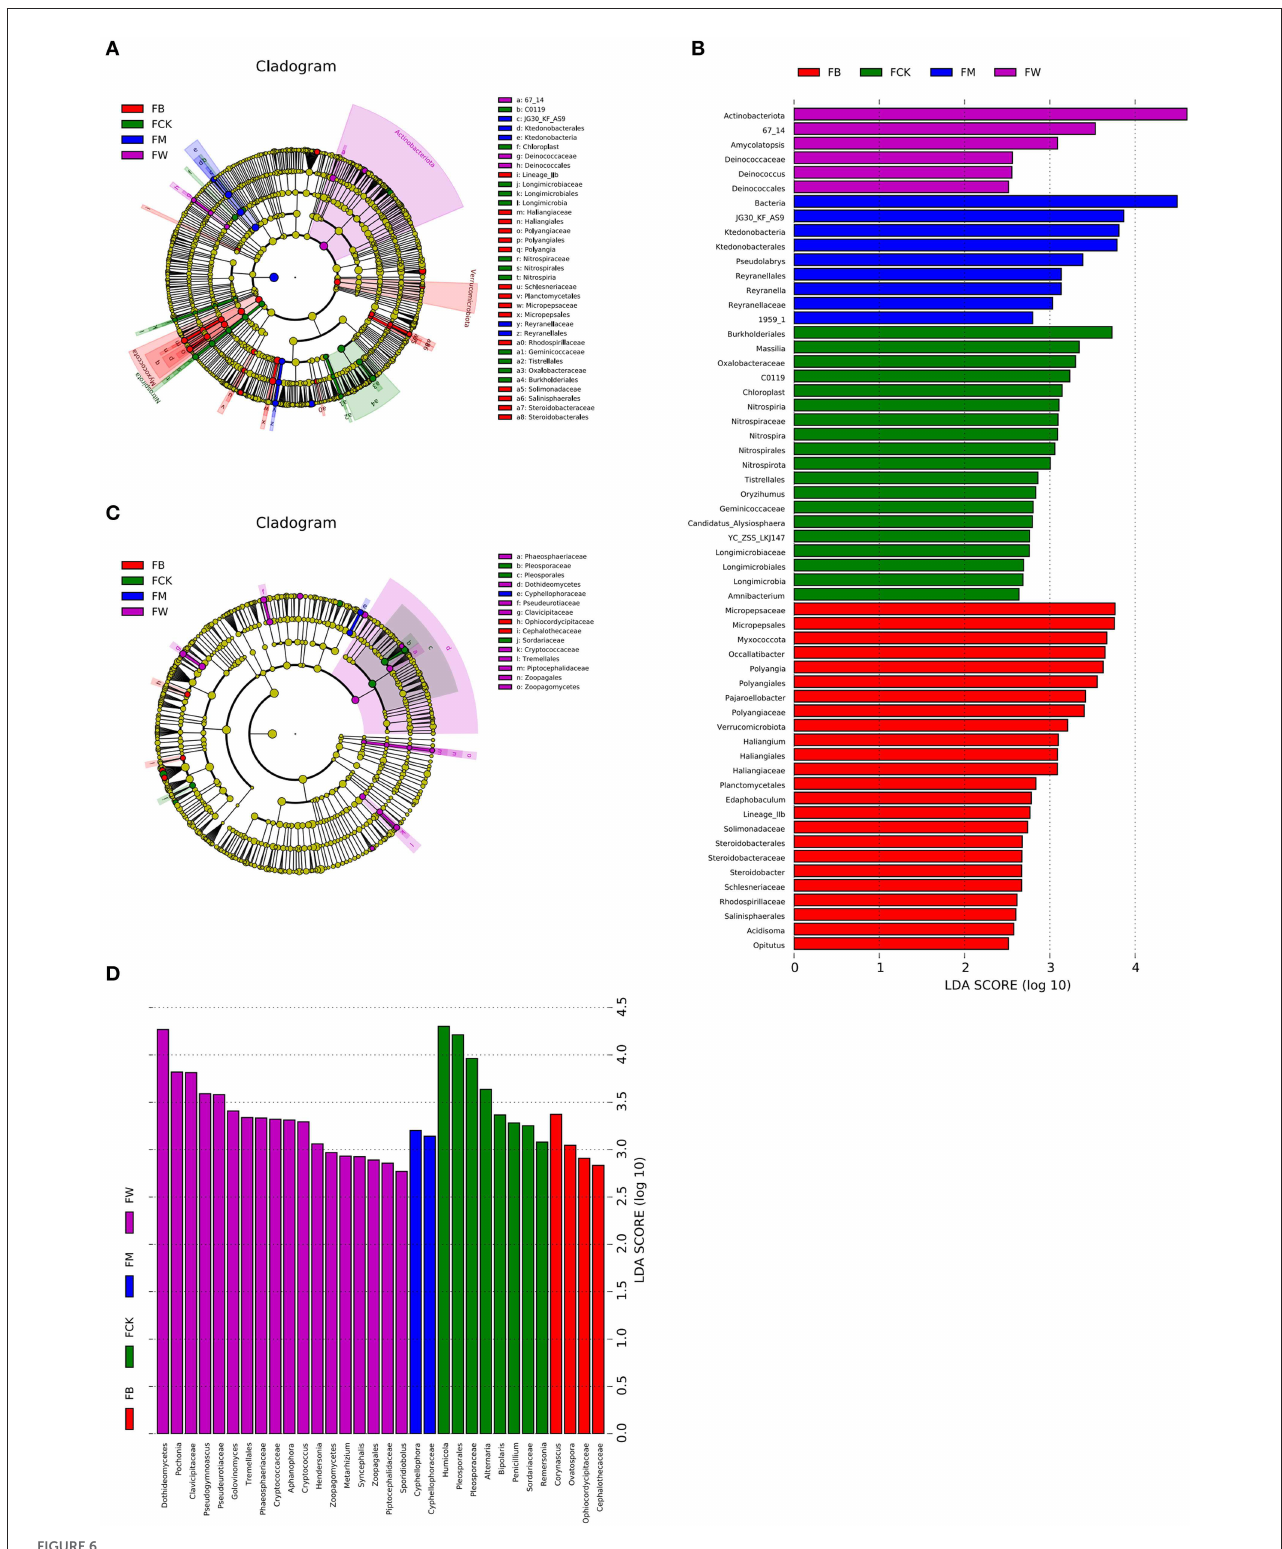
FIGURE6 Cladograms plotted from the LEfSe analysis show significant differences ( P < 0.05) in the relative abundance of 16S rRNA gene-based bacterial taxa among the four treatments before maize planting (A) . The results of LEfSe analysis show taxa that differed significantly among the four treatments before maize planting (B) . The cladogram plotted from LEfSe analysis shows significant differences ( P < 0.05) in the relative abundance of the ITS gene-based fungal taxa among the four treatments (C) . The results of LEfSe analysis show taxa that differed significantly among the four treatments (D)